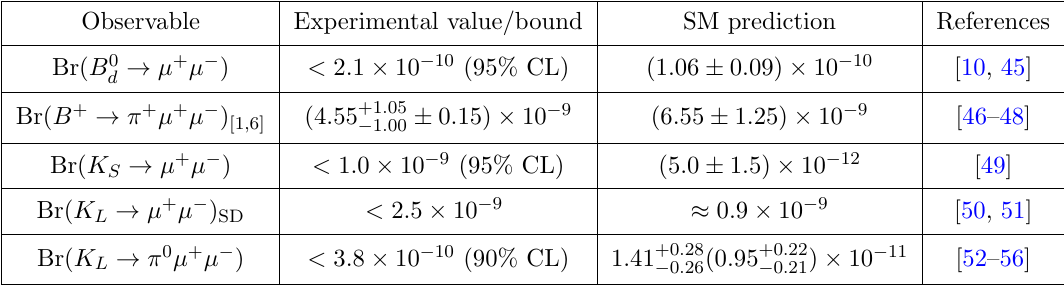
Table 4 . Observables with direct correlation with bs(cid:22)(cid:22)